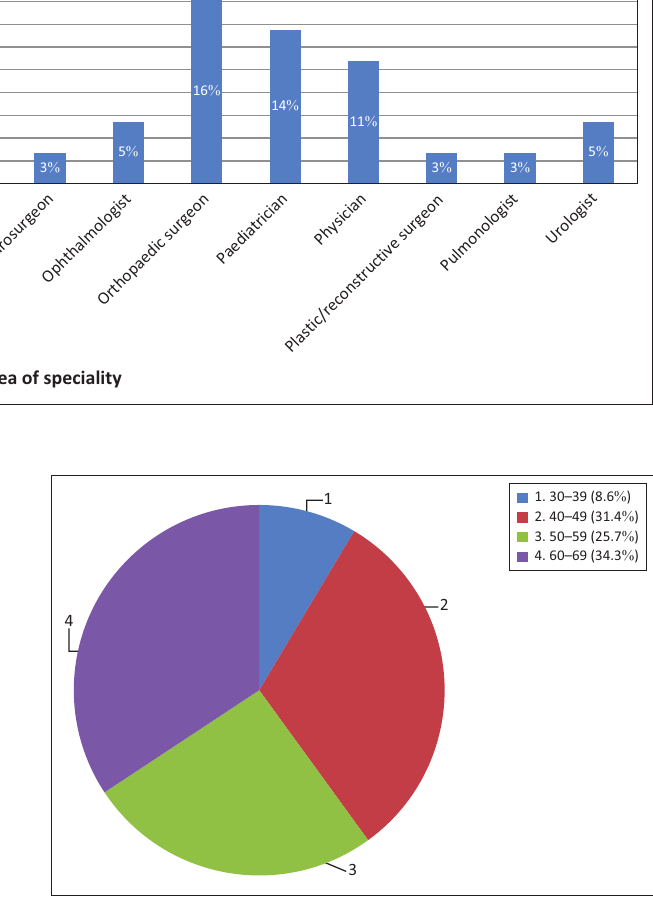
FIGURE 2: Participant age